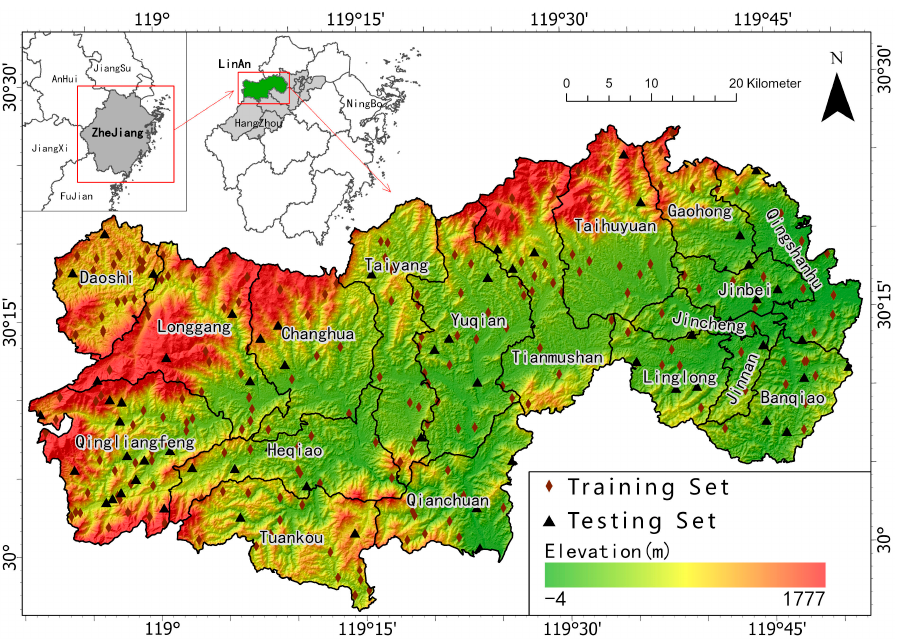
Figure 1. Location, elevation (m), towns, and landslide sample points in the study region. Note: type 0: sample points without landslide; type 1: sample points with landslide.